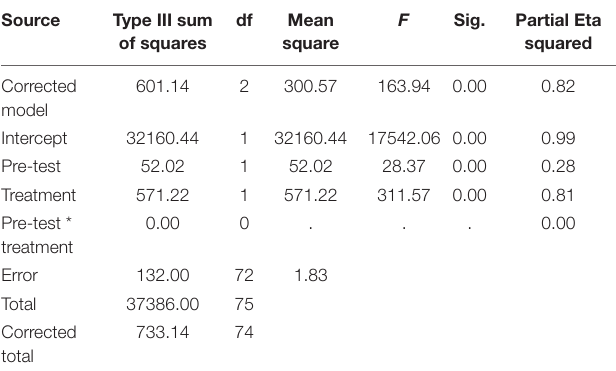
TABLE 5 | Results of two-way ANOVA for comparing the effects of ± treatment and ± pre-test conditions.